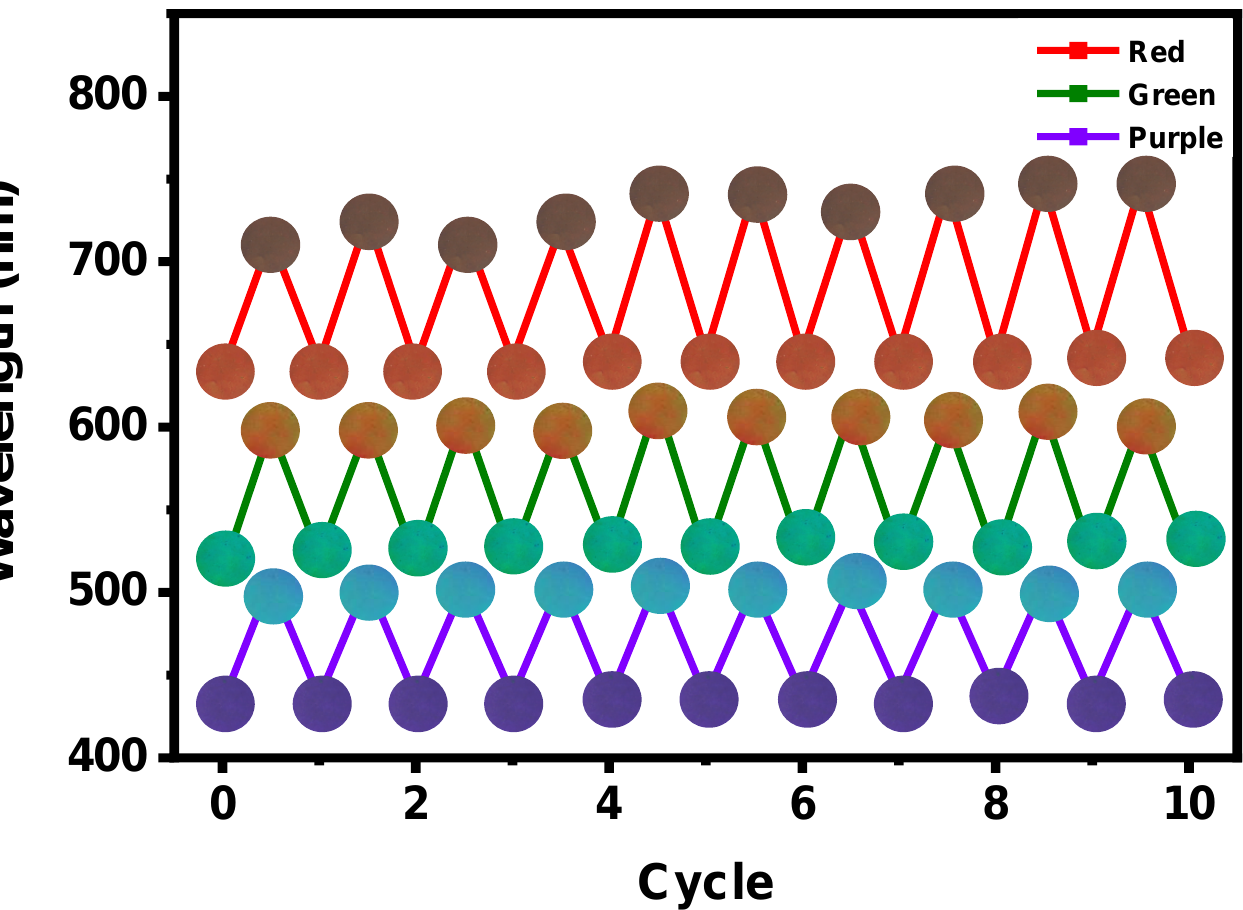
Figure 5. Changes in the maximum PSB after 10 cycles of alternating exposure of three films to human blowing.